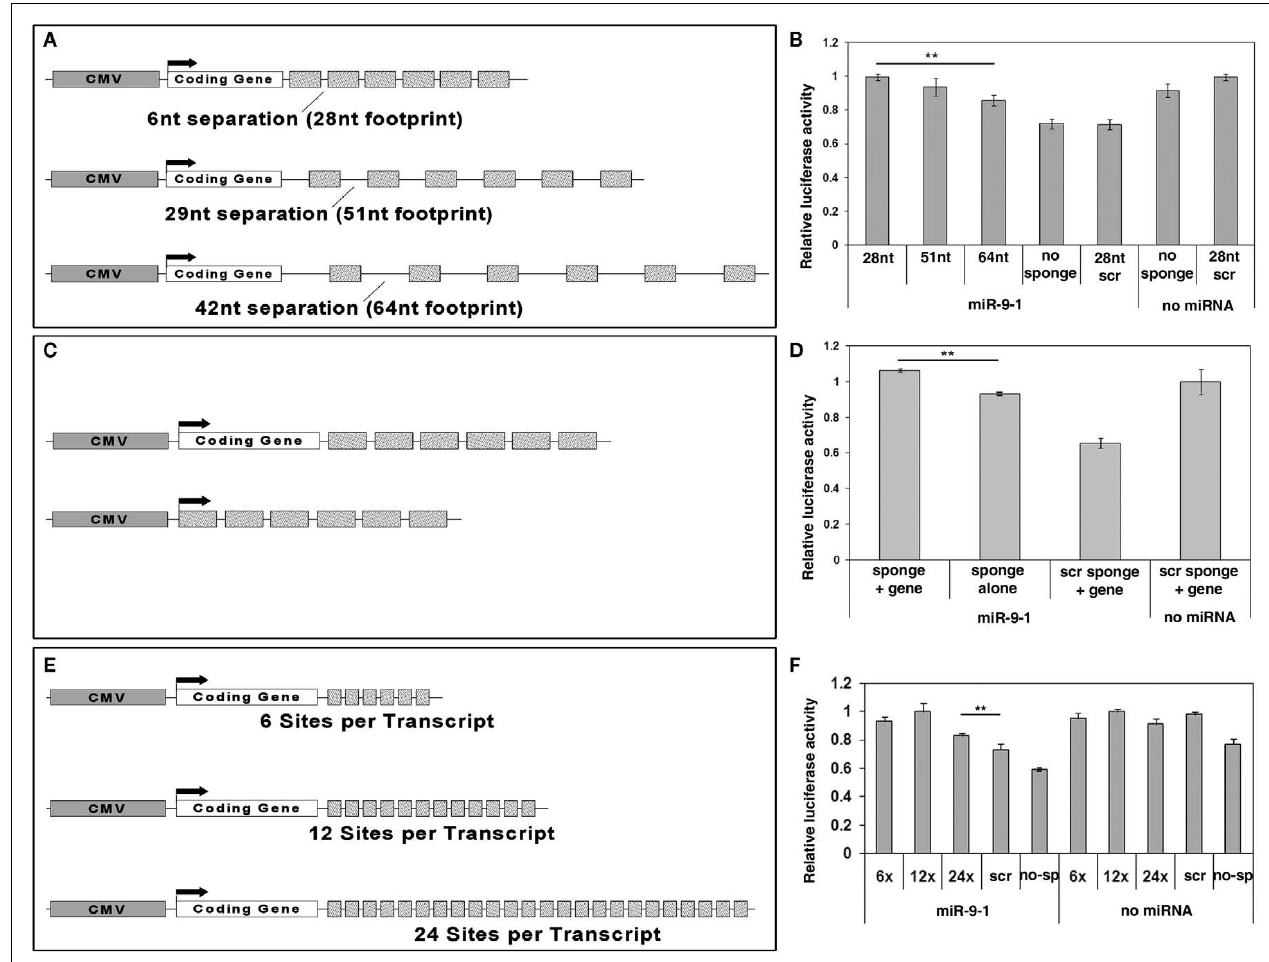
FIGURE 3 | Optimization of miRNA sponge designs. (A) A scheme of miR-9 sponge constructs with different spacers (separation) in between binding sites.The CMV promoter was used to drive sponge expression. 6, 29, or 42 nucleotides (nt) spacers with a 22 nt binding site permit a 28, 51, or 64 nt region respectively for one RISC to bind. (B) All miR-9 sponges blocked miR-9 silencing activity on FoxP1 3 (cid:2) -UTR in luciferase assays. Shorter spacers